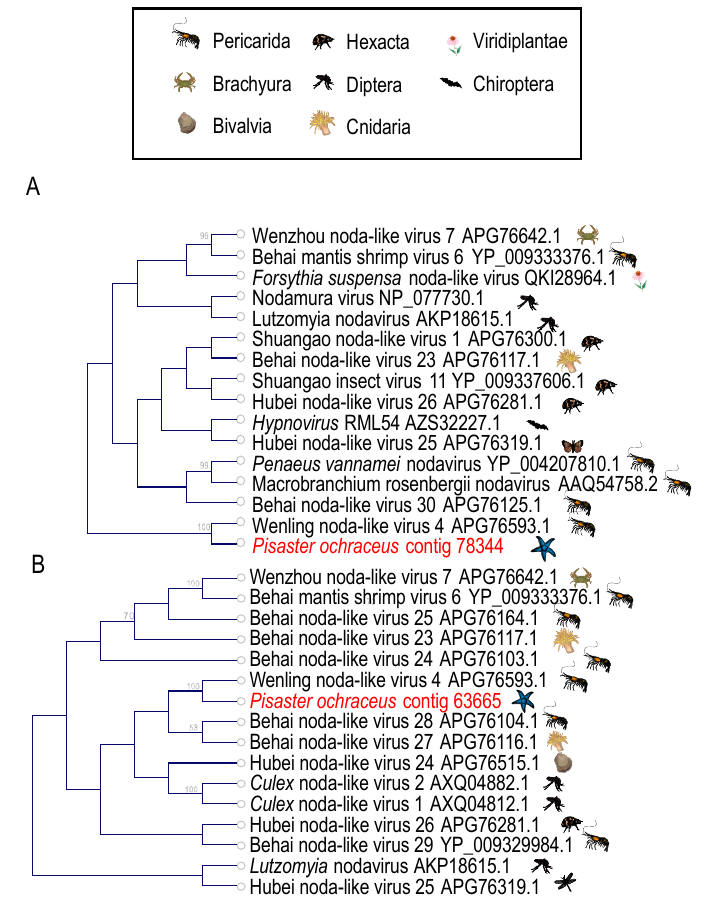
Figure 5. Phylogenetic representations of Nodamuvirales -like genome fragments recovered from Pisaster ochraceus . The trees were constructed based on a 101 amino acid ( A ) and 559 amino acid ( B ) alignments of the RNA dependent RNA polymerase gene of the nodavirus RNA1 genome fragment including best matches at NCBI. Trees were constructed by Neighbor Joining and based on Jukes-Cantor distance using CLC Genomics Workbench 4.0 (Qiagen). Bootstrap values > 50% (based on 1000 iterations) are indicated above nodes. The host identity is indicated by symbols next to branch labels. An additional phylogenetic representation of each tree based on maximum likelihood is presented in Figure